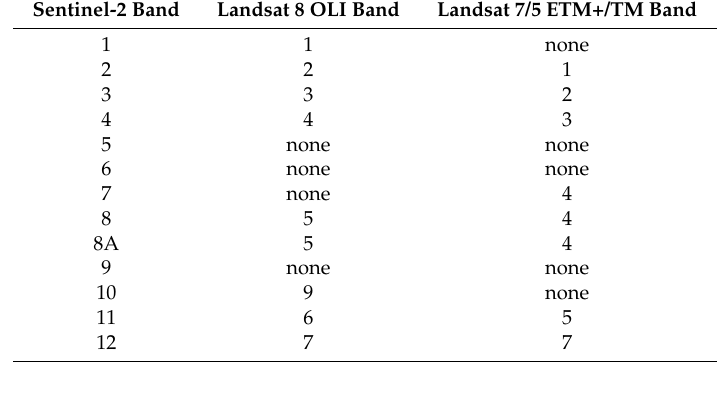
Table 5. The mapping relationships between Sentinel-2 bands and Landsat bands.